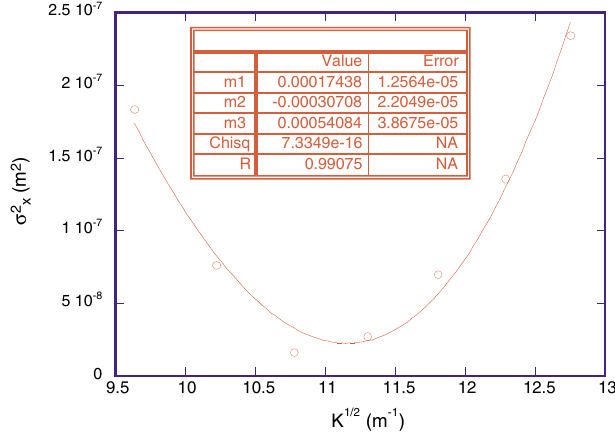
FIG. 13. (Color) Example data and fit for the thick lens quad scan of the central slice of a velocity-bunched beam. Here the mean square horizontal beam size is measured versus the focus- ing strength of the quadrupole, parametrized by K (cid:4) 299 : 8 B 0 (cid:2) T (cid:3) =pc (cid:2) MeV (cid:3) . The data is fitted to Eq. (3) (solid line) and the fit parameters are used to determine the rms emittance of the beam